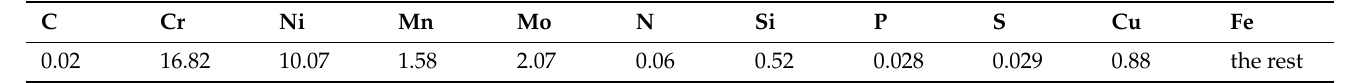
Table 1. Chemical composition of 316L austenitic steel, %